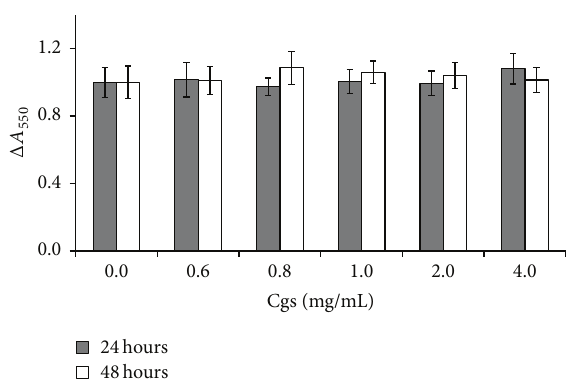
Figure 6: Relative number of PBMC ( Δ A 550 ) in the culture medium afterincubationfor24and48hourswithindicatedconcentrationsof CgsisolatedfromtheserumofpatientswithSCZ. Δ A 550 =numberof PBMC after incubation/number of PBMC before incubation. Δ A 550 for each given data point is significant ( P <